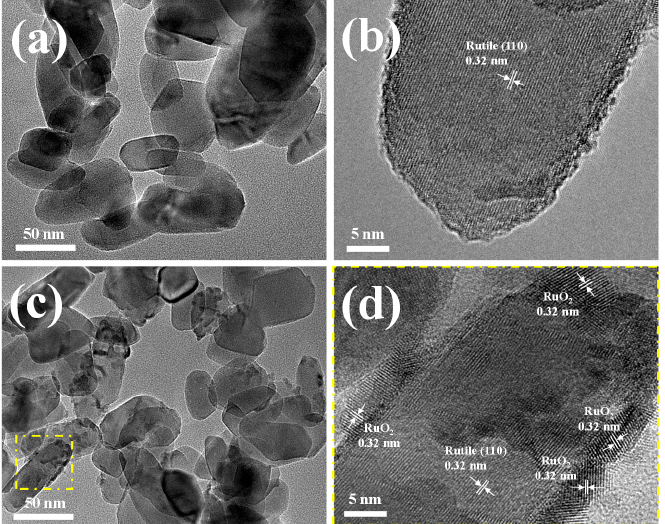
Figure 8. TEM and HRTEM images of the catalysts: ( a , b ) 1Ru/TiO 2 (Rutile), and ( c , d ) 1Ru-5Ce/TiO 2 (Rutile).